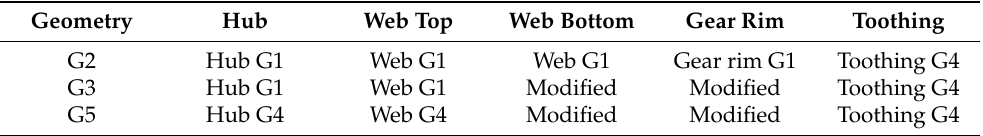
Table 2. Used local heat transfer descriptions.